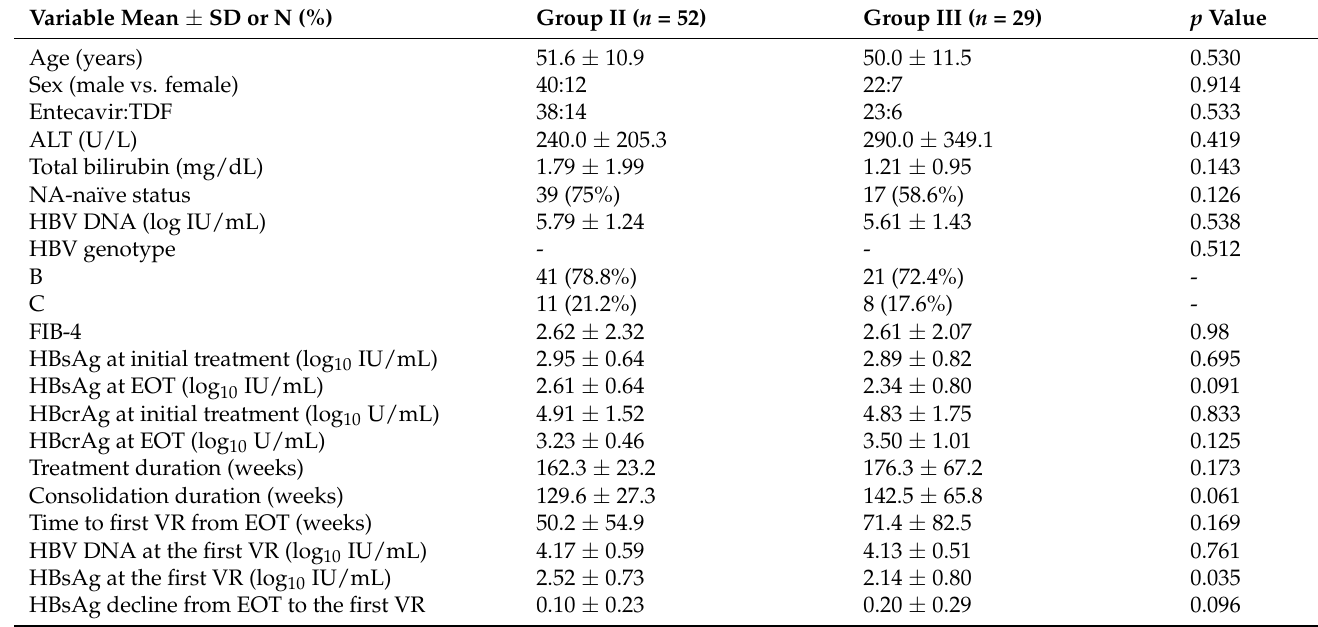
Table 2. Clinical features of patients without (Group II) and with (Group III) persistent virological remission after virological relapse without clinical